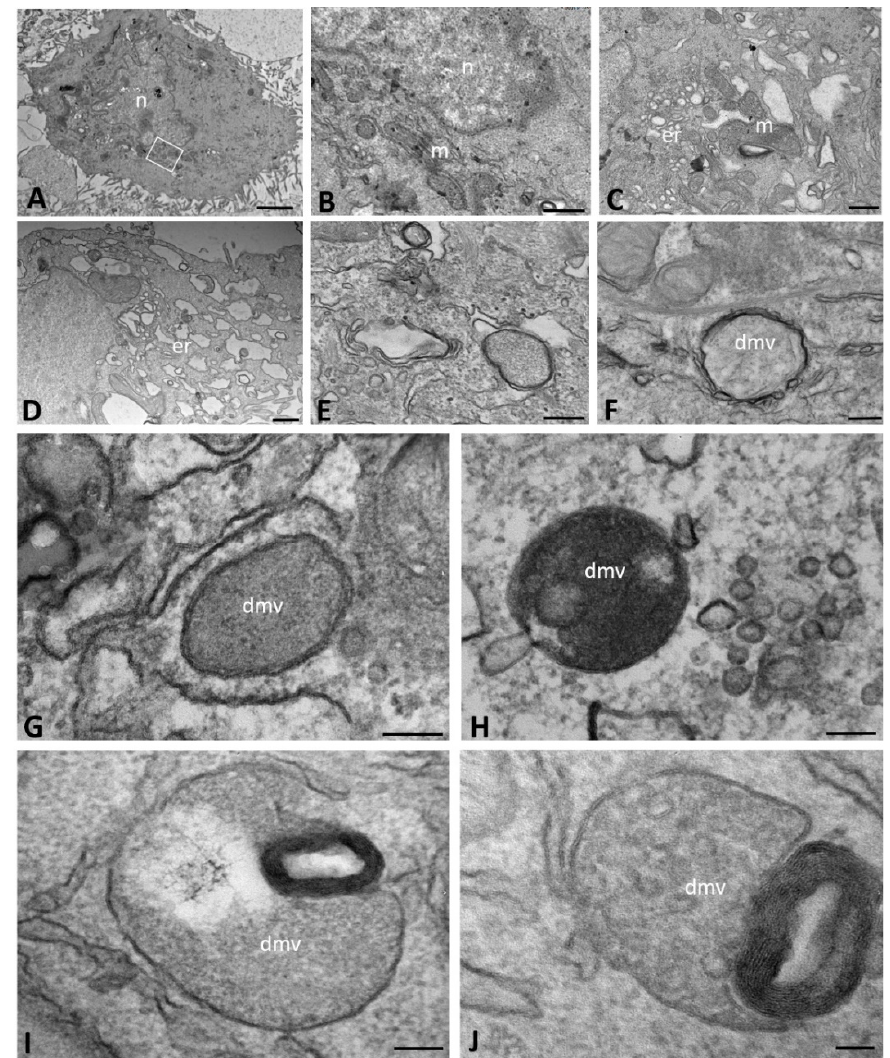
Figure 4. Transmission electron microscopy showing the morphology of mock-infected ( A – C ) and SARS-CoV-2-infected ( D – J ) CFBE41o- ∆ F cells at early time points of infection (from 1 to 6 h post infection). Double-membrane vesicles with granular ( E – I ) and vesicular ( J ) content are visible. The boxed area in ( A ) is enlarged in ( B ). (dmv): double-membrane vesicle; (m): mitochondria; (n): nucleus. Bars: ( A ) 2 µm; ( B , C ) 500 nm; ( E , F ) 200 nm; ( G – I ) 100 nm; ( J ) 50 nm.